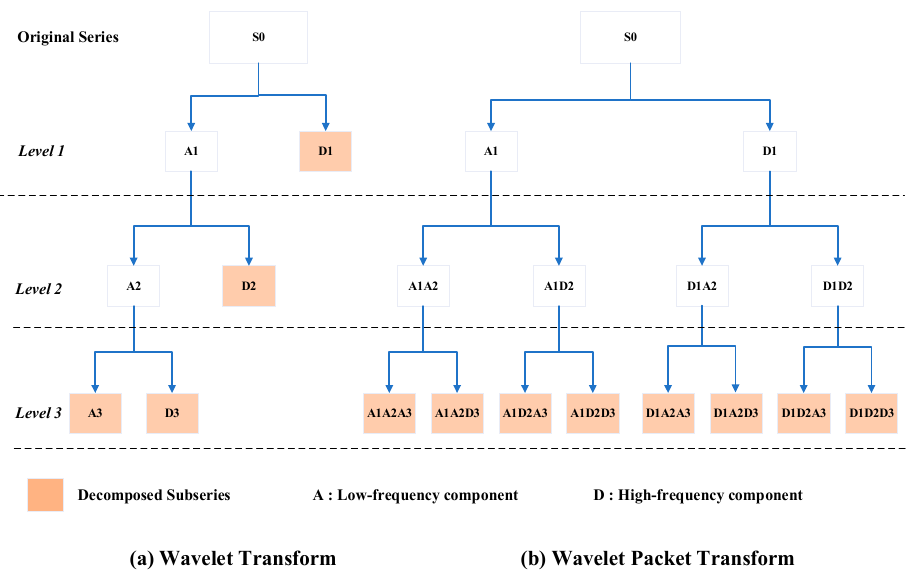
Figure 3. Schematic of wavelet decomposition and wavelet packet decomposition.